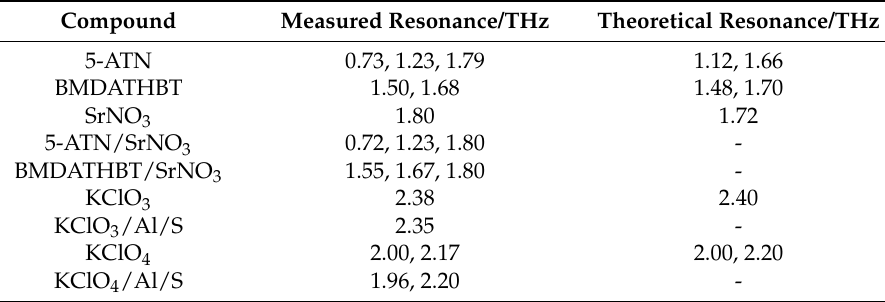
Table 1. Absorption peaks of nitrogen compounds, oxidizers, and mixtures. Compound Measured Resonance/THz Theoretical